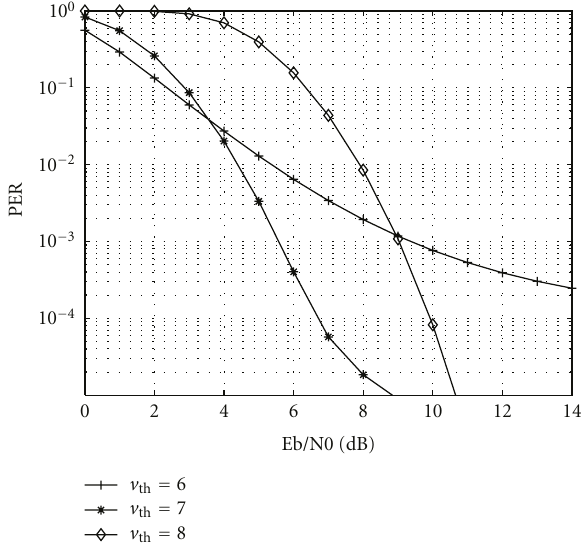
Figure 8: Influence of the v th level on 8-PIM performance with code weight w = 10 .